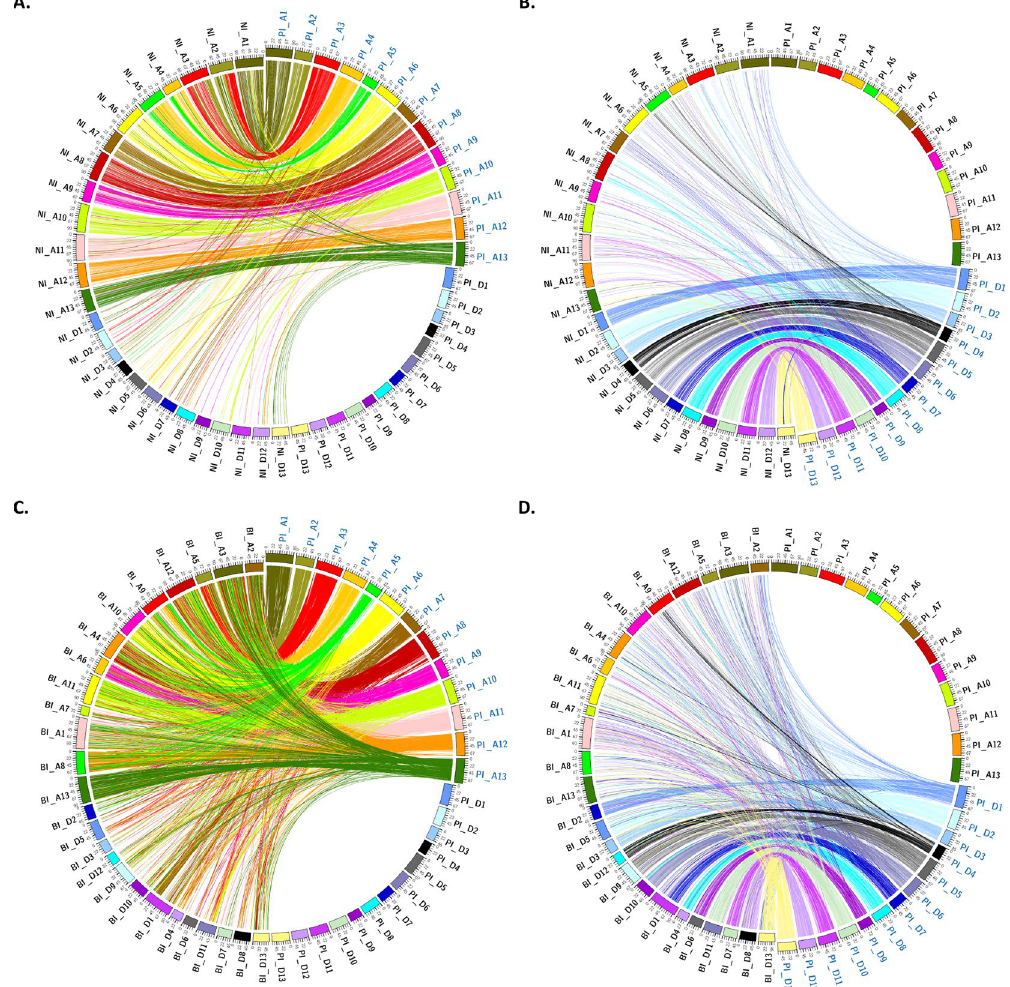
Figure 2. ( A ) Alignment of the G. hirsutum inbred TM-1 A-sub genome physical map pseudomolecules (PI) to the International Cotton Sequencing Consortium draft sequence (NI). ( B ) Alignment of the G. hirsutum D-sub genome PI pseudomolecules to the corresponding NI draft assemblies. ( C ) Alignment of the G. hirsutum A-sub genome physical map pseudomolecules (PI) to the Institute of Cotton Research (BI) draft sequence. ( D ) Alignment of the G. hirsutum D-sub genome physical map pseudomolecules (PI) to the corresponding BI draft sequences. Colored ribbons connect BAC physical map contigs to the respective reference genome assemblies with alignment criteria of 98% identity and a cluster of at least 6 contiguous BAC end